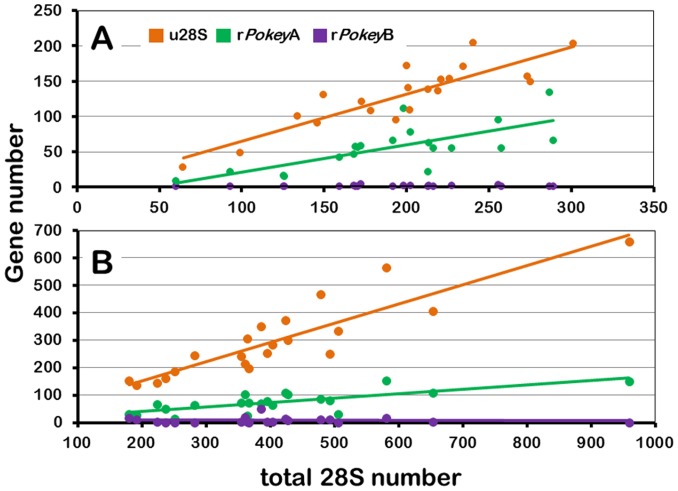
Regression of Pokey and 28S rRNA gene number in isolates of Daphnia obtusa.(A) Isolates from 20 mutation accumulation lines sampled at generation ∼87 (MAL-87). (B) Twenty-one isolates from natural populations (NP) in the eastern and Midwestern USA. u28S  =  uninserted 28S genes, rPokeyA  =  PokeyA elements in rDNA, rPokeyB  =  PokeyB elements in rDNA.